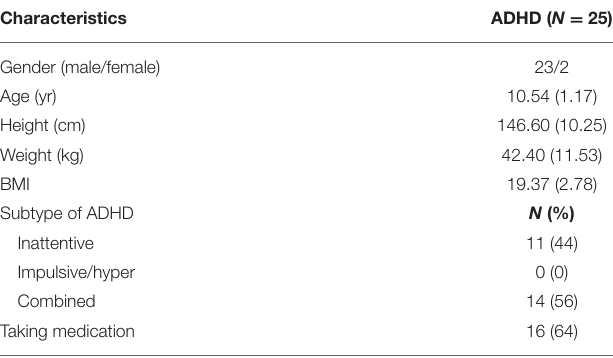
TABLE 1 | Demographic characteristics of